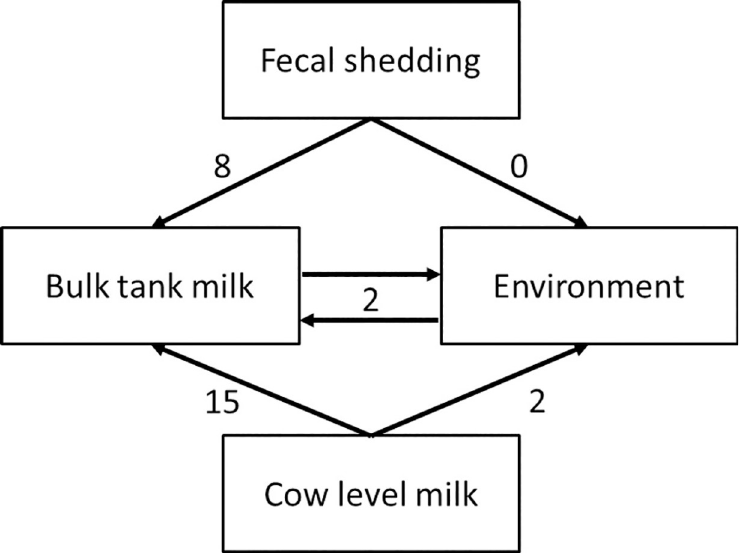
Fig 2. Potential within-farm transmission routes of group B streptococcus (GBS) . Numbers over the arrows represent the number of farms where MSLT results support the link.